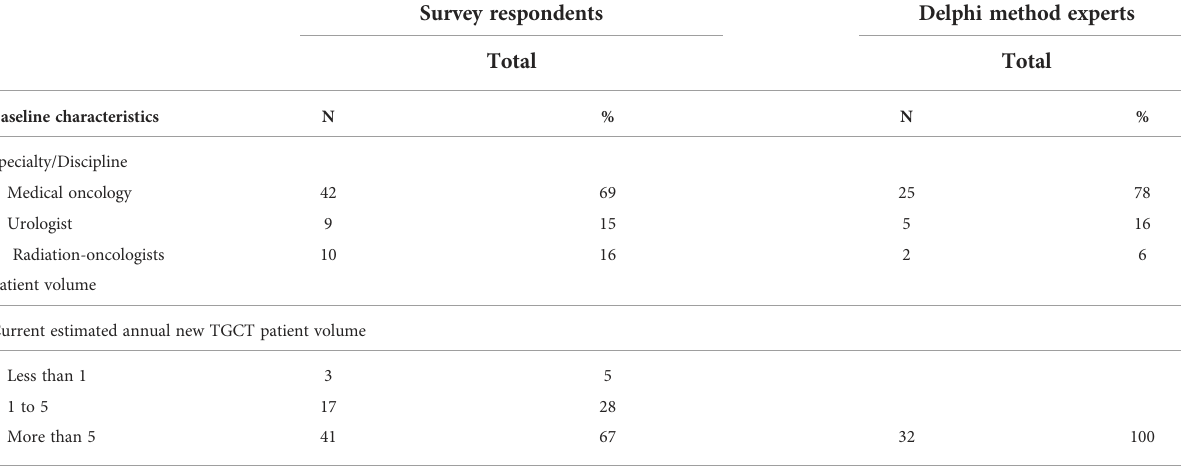
TABLE 1 Baseline characteristics of survey respondents and Delphi consensus method